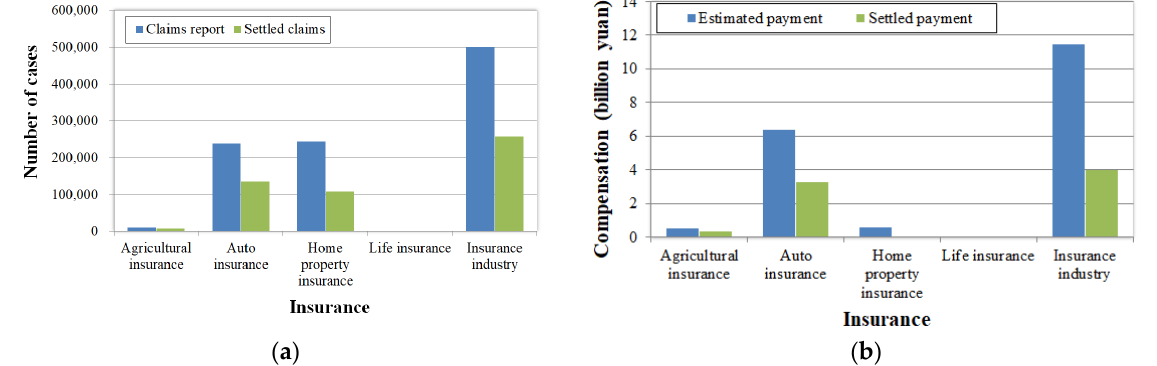
Figure 19. Compensation granted by insurance industry: ( a ) reported and settled cases of insurance claims; ( b ) estimated and settled claim payments.